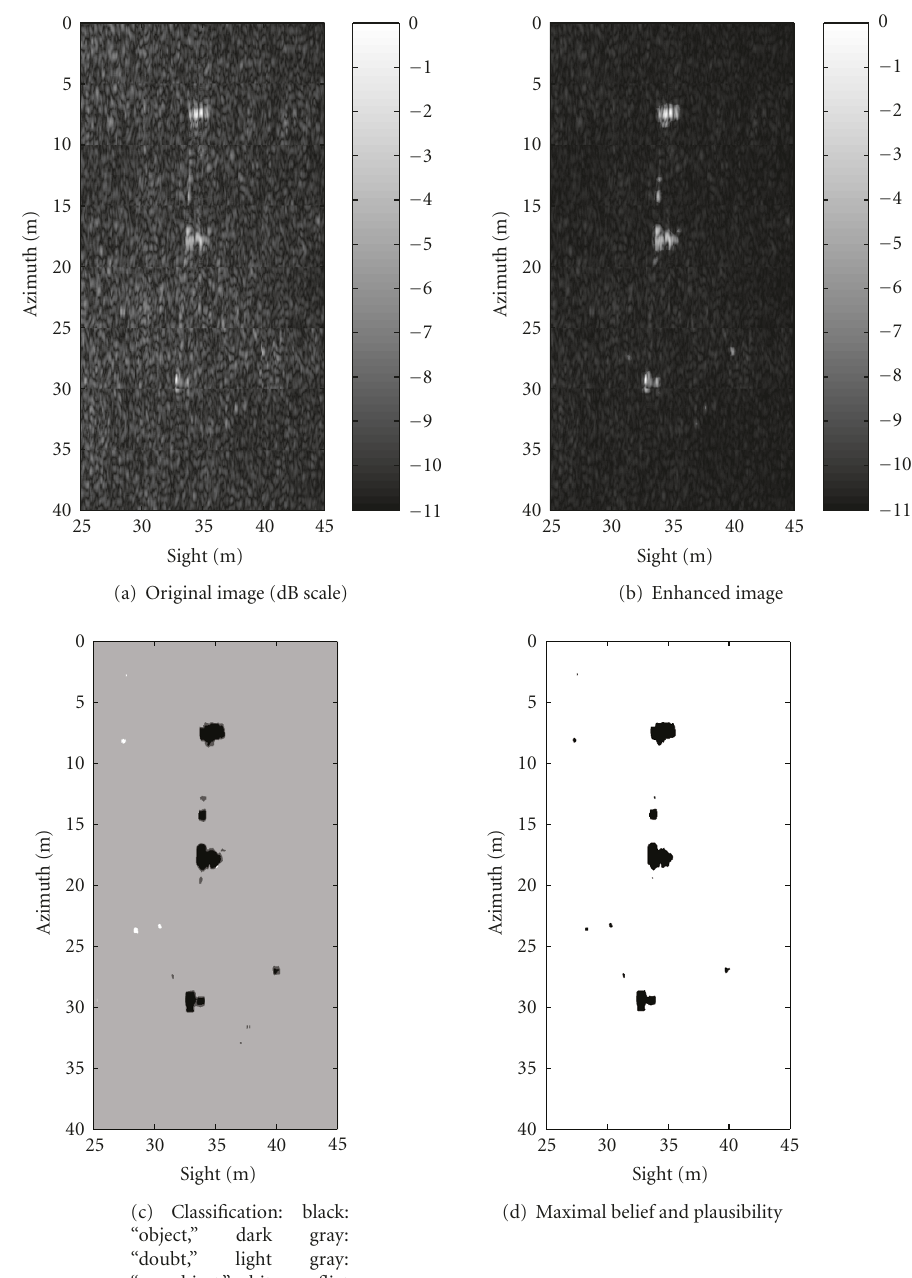
Figure 11: Presentation of the fusion results—image